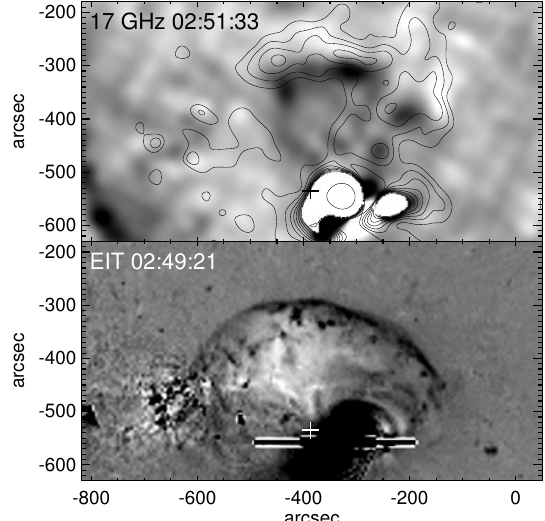
Figure 13: Top: the wave event of 1997 Sep 24 imaged at 17 GHz with the Nobeyama radioheliograph. Shown is a difference image (with reversed gray table) on which contours of the base image are overplotted. An arc-shaped front of increased brightness temperature is clearly seen to the north of the associated flare. Bottom: the associated sharp EIT wavefront shown in a difference image. Image reproduced with permission from White and Thompson (2005), copyright by